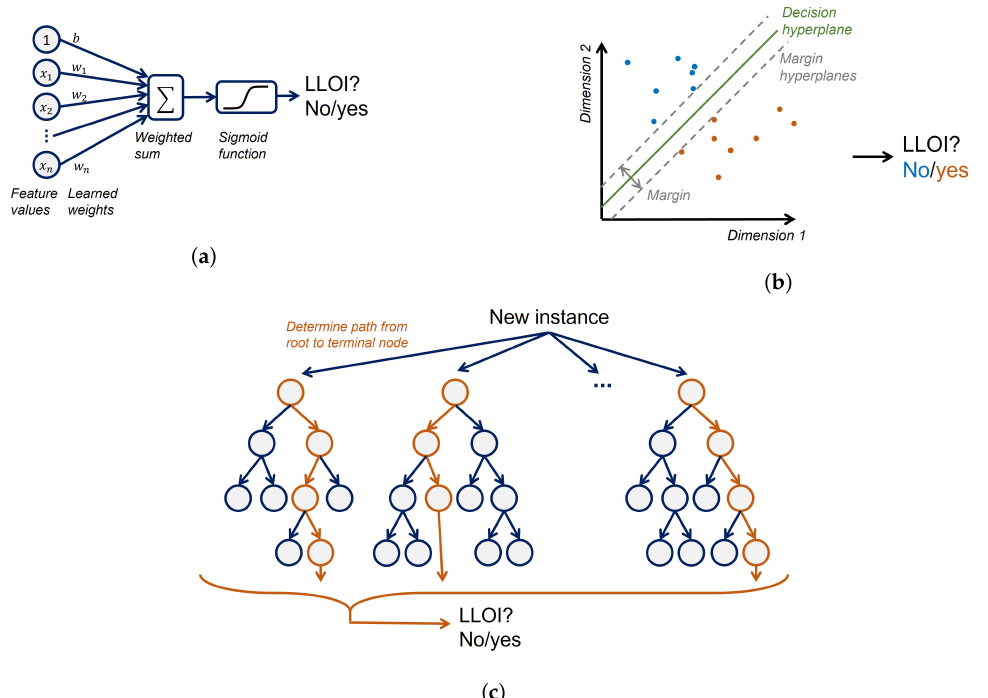
Figure 3. Simplified diagrams showing how the three used models classify instances. ( a ) In a logistic regression model, a weighted sum of the feature values is mapped with a sigmoid function onto the probability of a future occurrence of a lower-limb overuse injury (LLOI) ( b ) A support vector machine learns a maximum margin hyperplane that separates LLOI from non LLOI. New instances are classified by determining on what side of the learned hyperplane they lie. ( c ) A random forest consists of multiple trees. For a new instance, a path from the root to a terminal node (orange path) is determined according to the instance’s feature values. Each terminal node contains a probability distribution over the classes, and the final prediction is determined by averaging these probability